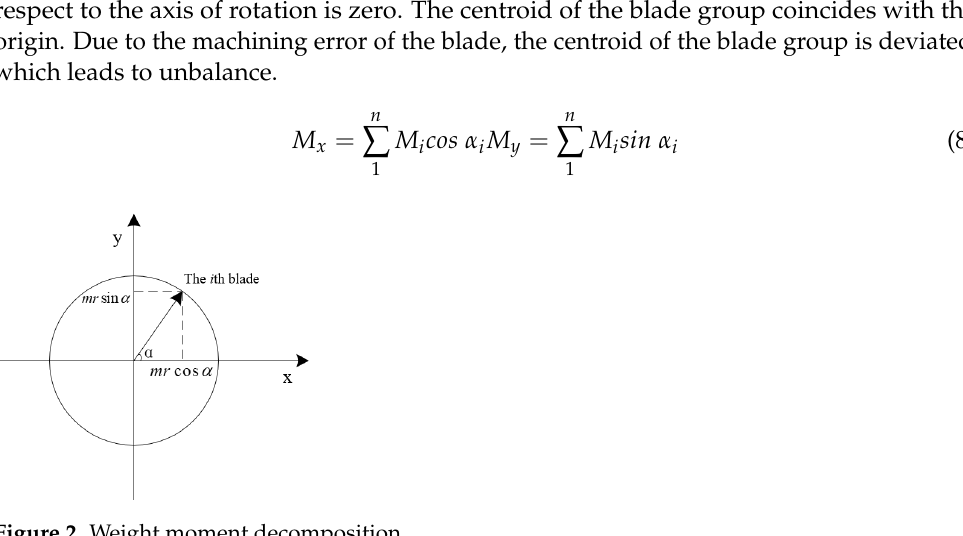
Figure 2. Weight moment